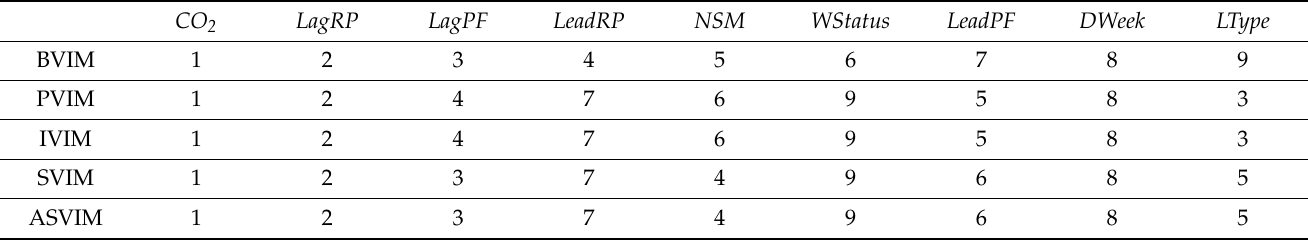
Table 5. Ranking of predictors of energy consumption in a steel plant based on median values